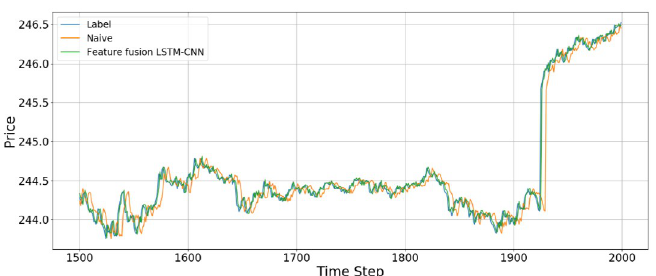
Fig 18. An example of predicting stock prices using the feature fusion LSTM-CNN model with a test dataset of between 1,500 and 2,000 data points. The input data are candlebar chart and stock time series.